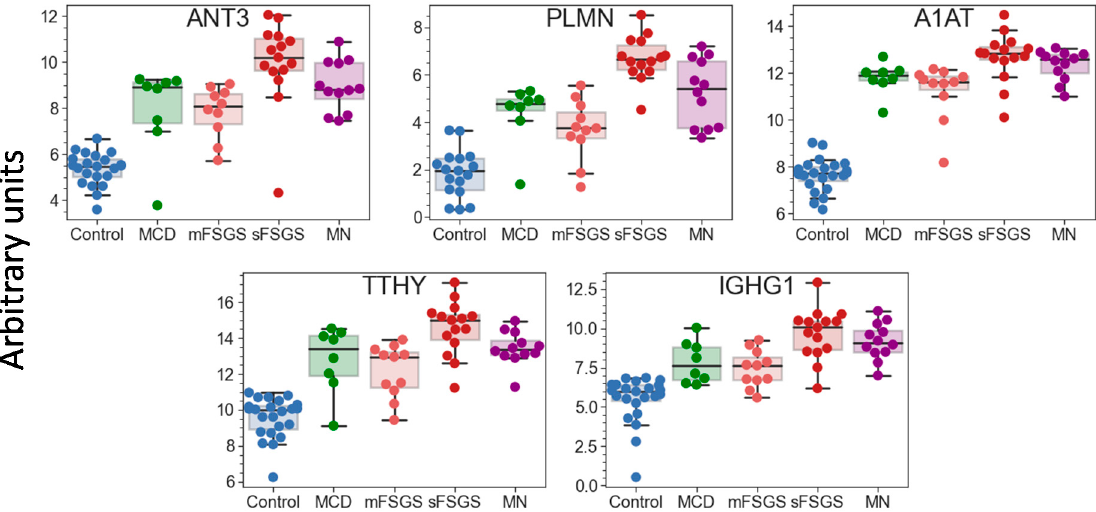
Figure 2. Boxplots for 5 urinary proteins that revealed the greatest number of differences between the control and glomerulopathy groups at FDR < 0.01 (Benjamini–Hochberg). The protein levels are shown in arbitrary units on an Ln(x + 1) scale. Abbreviations: ANT3—antithrombin-III; PLMN— plasminogen; A1AT—alpha-1-antichymotrypsin; TTHY—transthyretin; IGHG1—Ig gamma-1 chain C region.